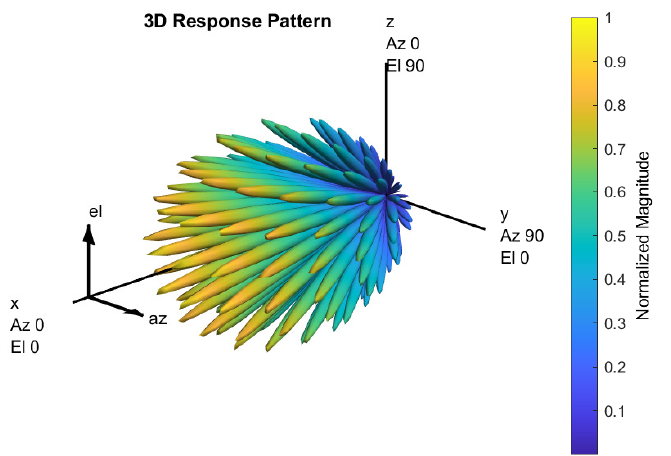
Figure 2. Radiation pattern of all the beams obtained with a 5G-NR antenna array designed as a DP single-panel UPA with 𝑁 1 = 𝑁 2 = 2.